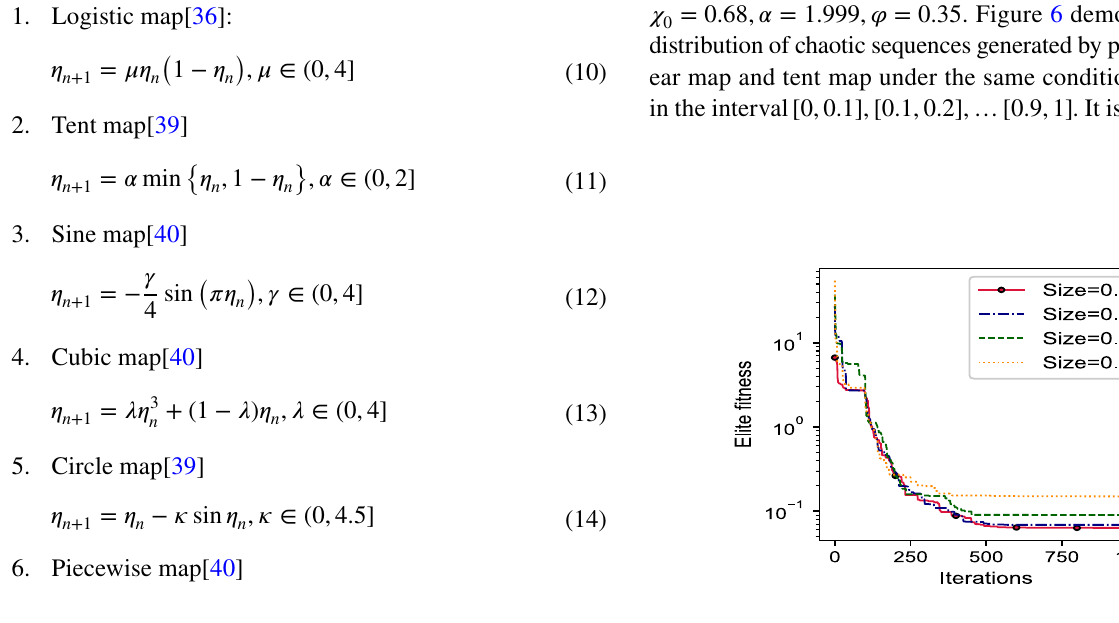
Fig. 3 Convergence curves of different walk sizes in test function